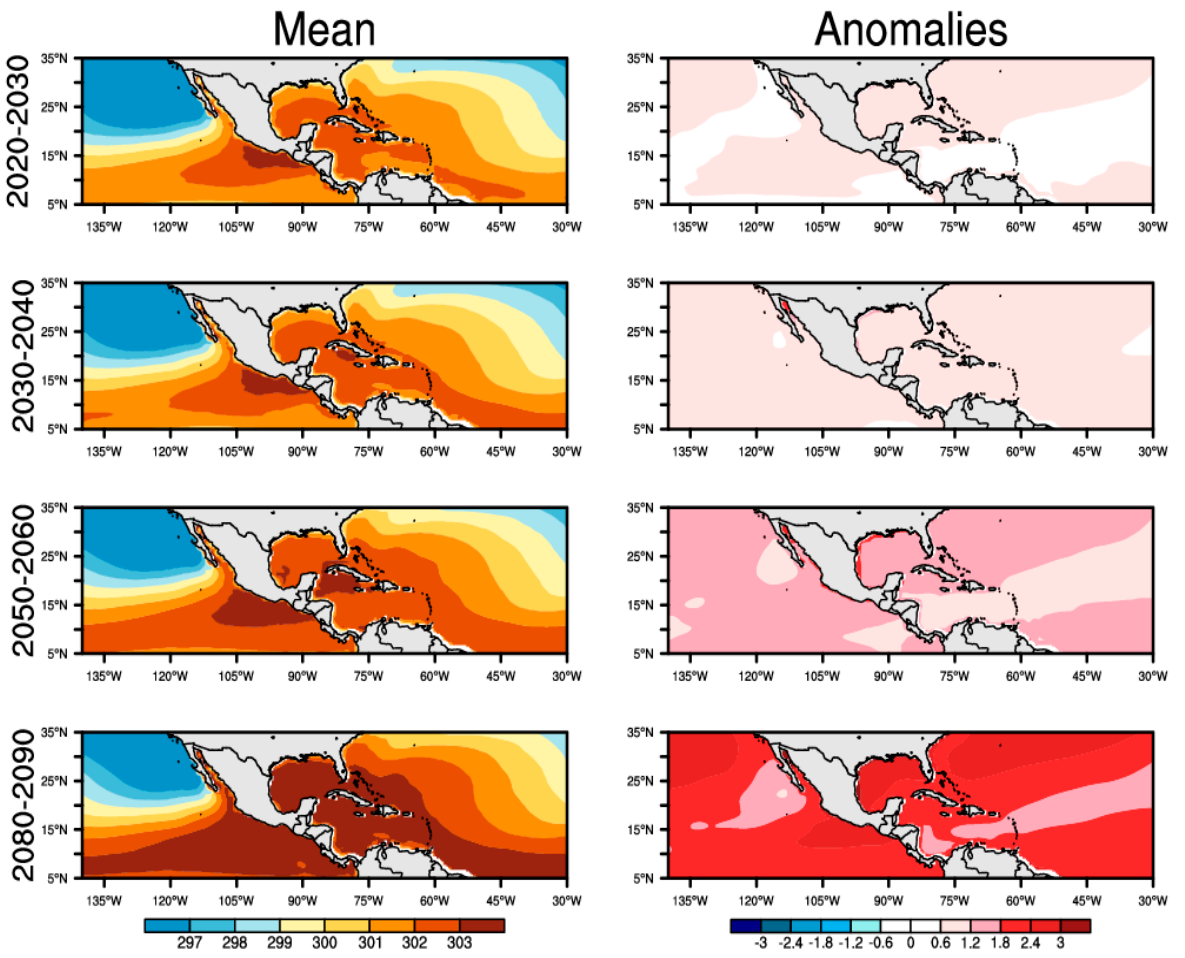
Figure 2. Annual mean (K degrees) and mean anomalies (K degrees) of sea surface temperatures over Tropical North America with respect to the reference period (1990–2000).